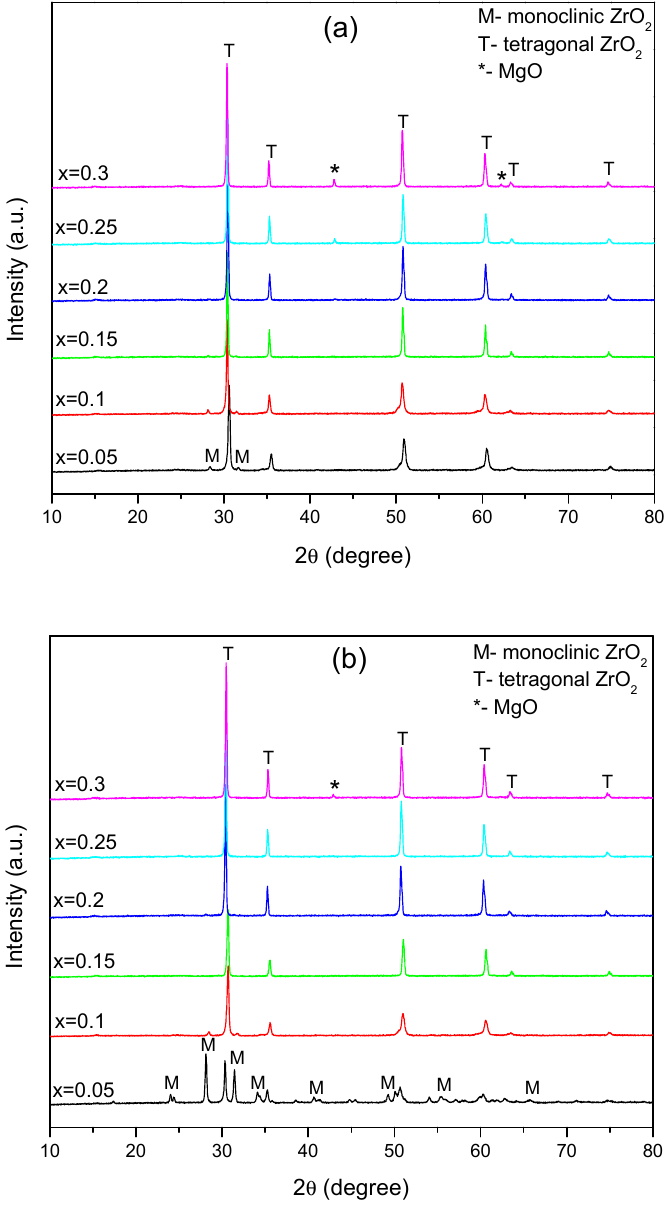
Figure 1. XRPD pa tt erns of compositions belonging to Zr 1-x Mg x O 2 (x = 0.05, 0.1, 0.15, 0.2, 0.25, 3) bioceramics ( a ) before and ( b ) after immersion in Xerostom ® bioceramics ( a ) before and ( b ) after immersion in Xerostom ® .